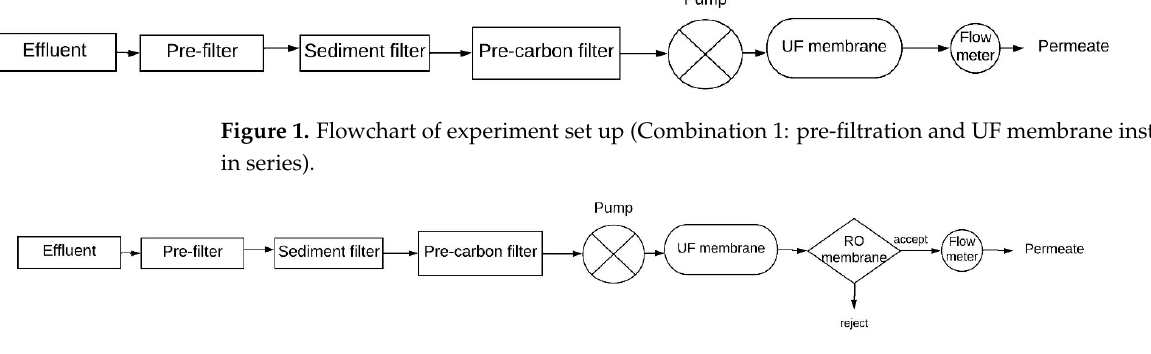
Figure 2. Flowchart of experiment set up (Combination 2: pre-filtration, UF membrane and RO membrane in series).